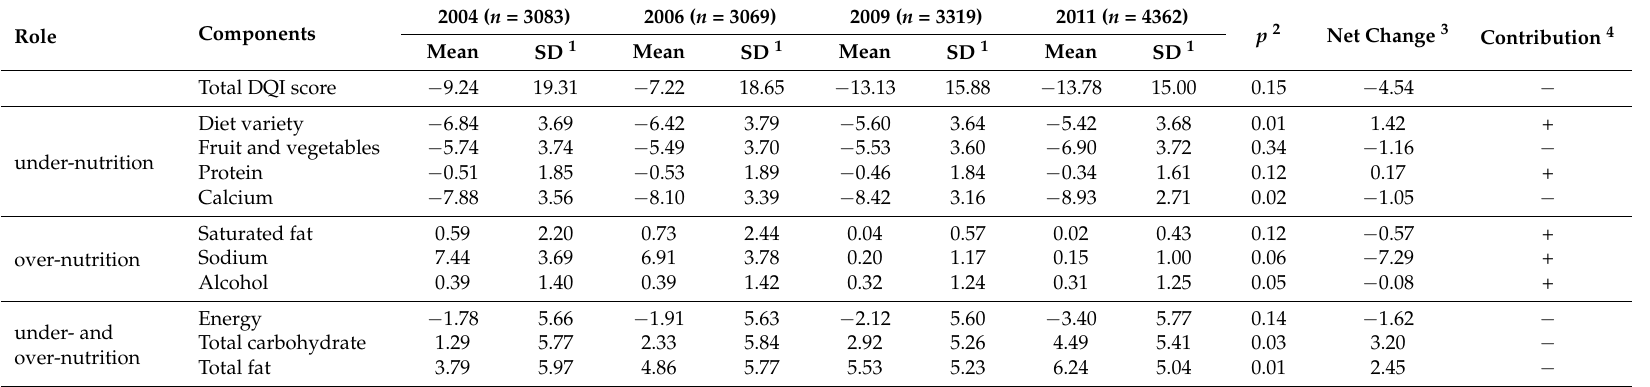
Table 2. Changing diet quality index (DQI) scores and its